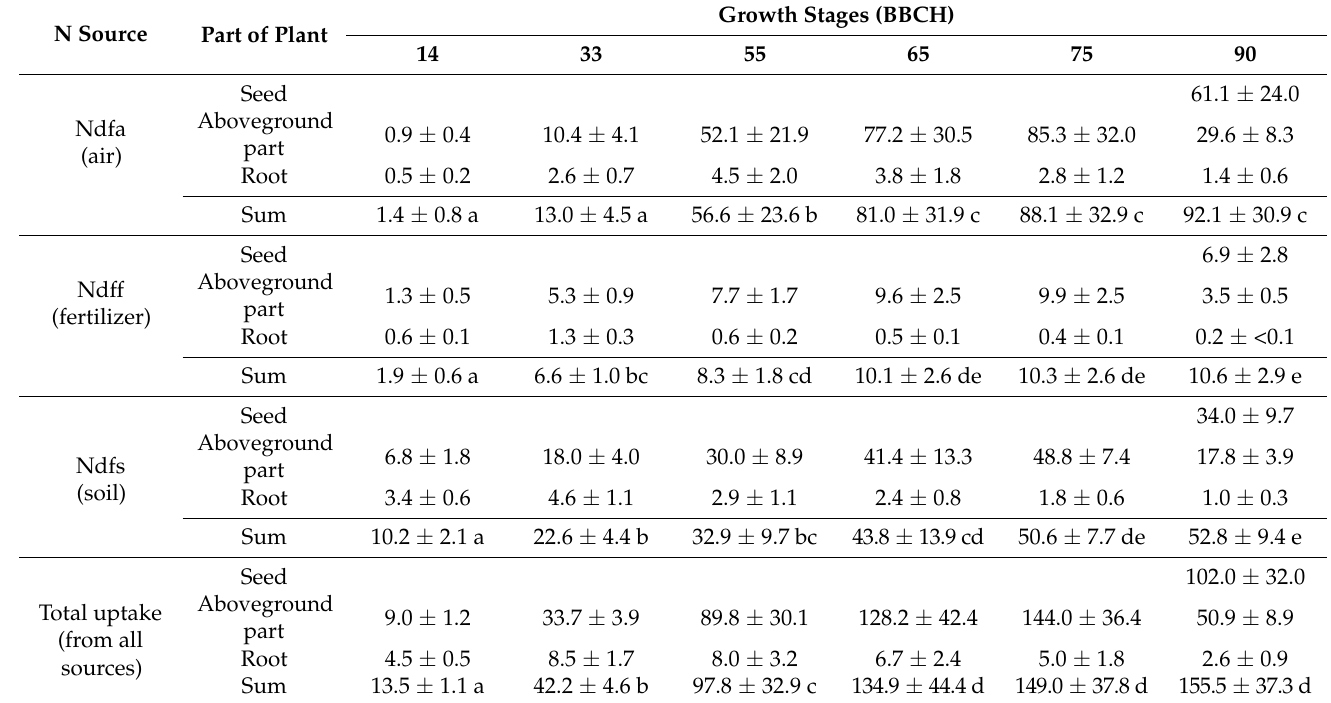
Table 7. Amount of nitrogen taken up by pea from different sources in following growth stages, kg N · ha − 1 (meanly from three replications, cultivars, and years ±